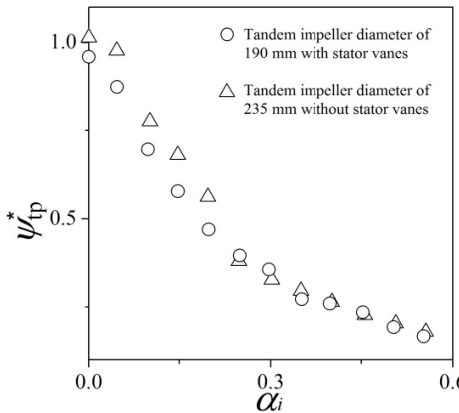
Figure 13. Example of two ‐ phase performance ratio using tandem blade arrangement (this figure has been reproduced from reference been reproduced from reference [34]).